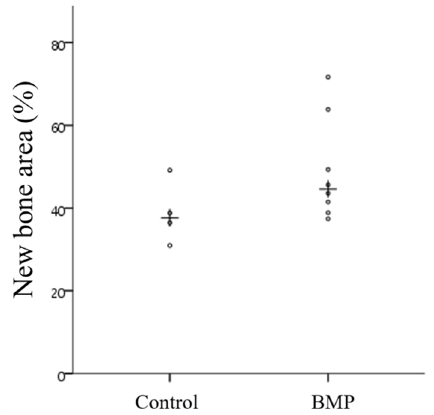
Figure 11. Scatter plot and median (the cross) representing the new bone area (%) ( p > 0.05).